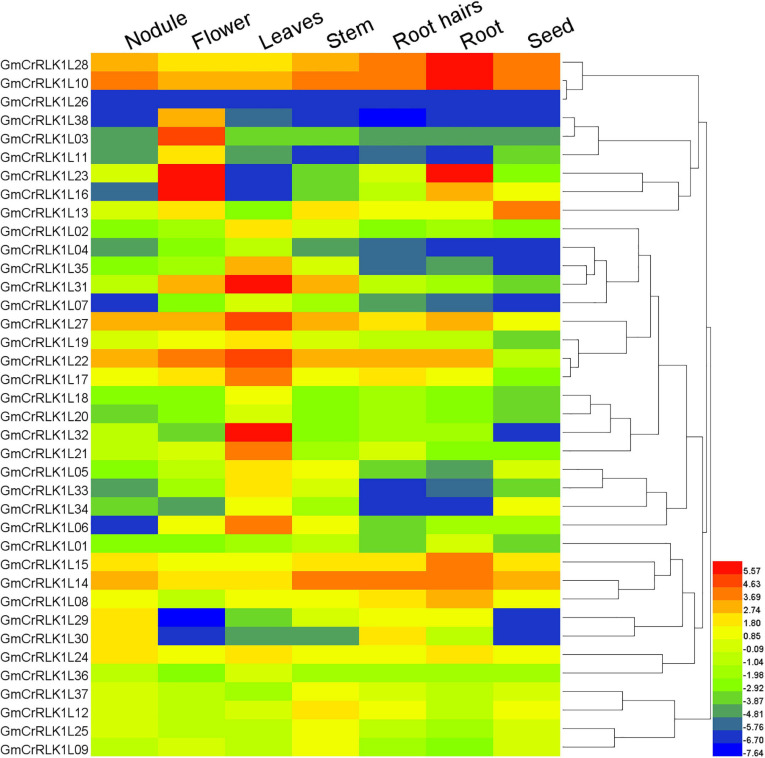
Expression profiles of soybean CrRLK1L genes from seven soybean tissues (seeds, roots, root hairs, stem, leaves, flowers, and nodules). Gene expression values are represented by different colors. The color scale is displayed at right of figure.